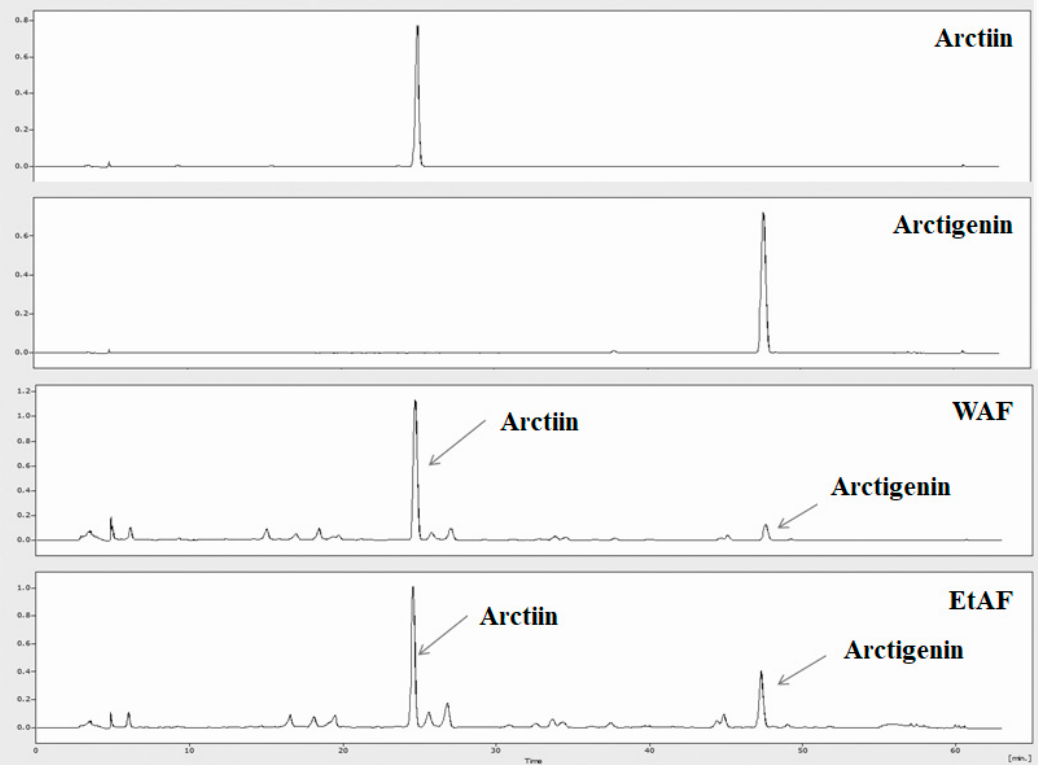
Figure 1. HPLC of major compounds of Arctii Fructus (AF). The chromatographic peaks of arctiin, arctigenin, WAF, and EtAF.